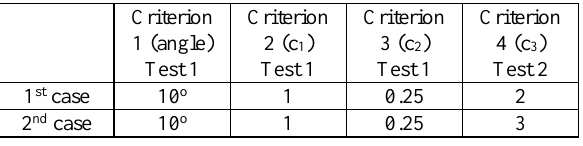
Table 1. Parameters of the criteria for wall part of Figure 4